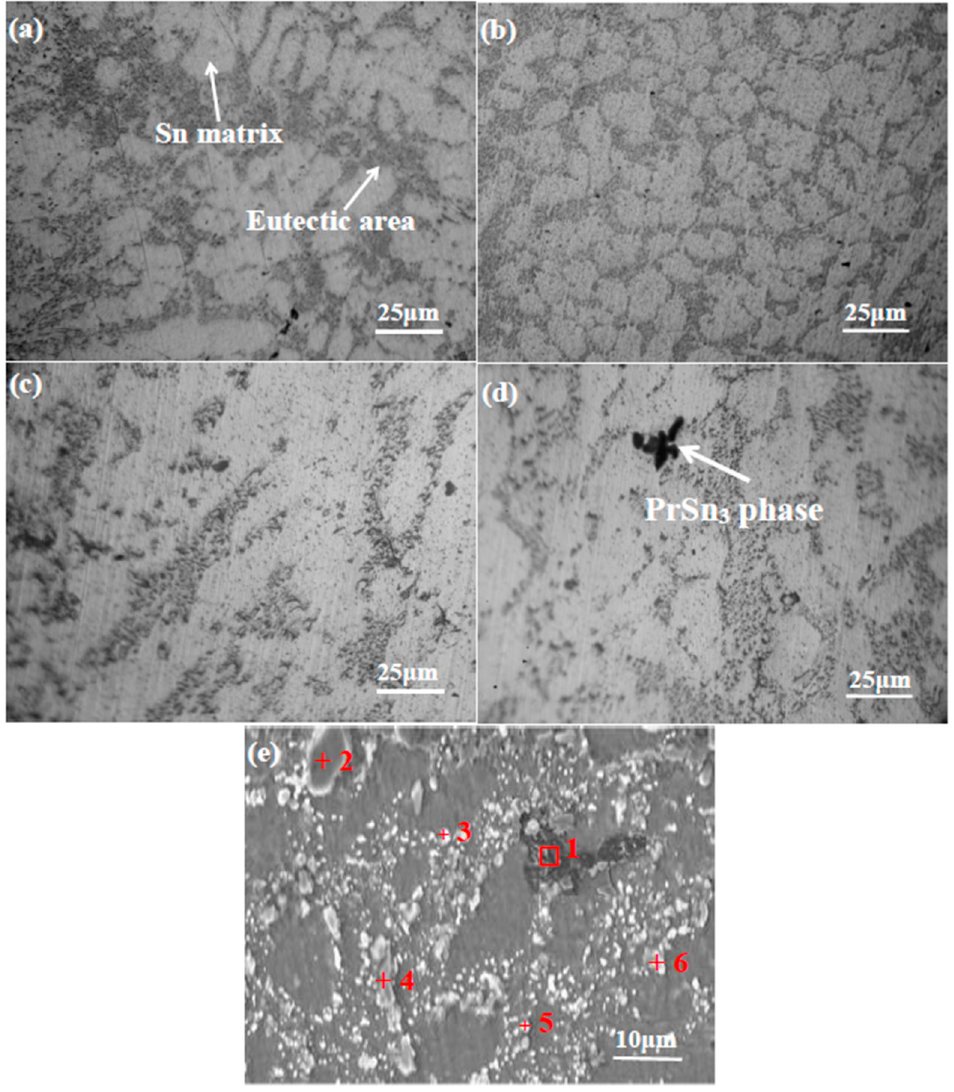
Figure 1. OM Microstructure of ( a ) SAC0307 solder; ( b ) SAC0307-0.05Pr solder; ( c ) aged SAC0307 solder at 150 ◦ C for 840 h; ( d ) aged SAC0307-0.05Pr solder at 150 ◦ C for 840 h, ( e ) SEM image of aged SAC0307-0.05Pr solder at 150 ◦ C for 840